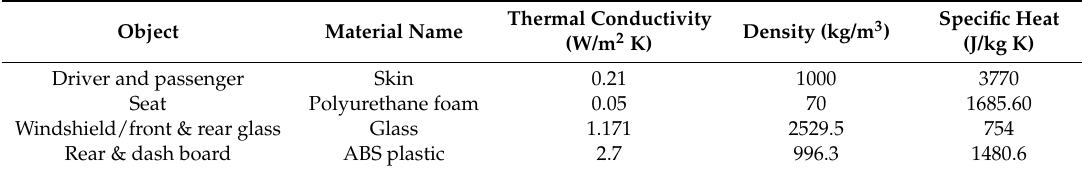
Table 2. Material Properties for Thermal Fluid